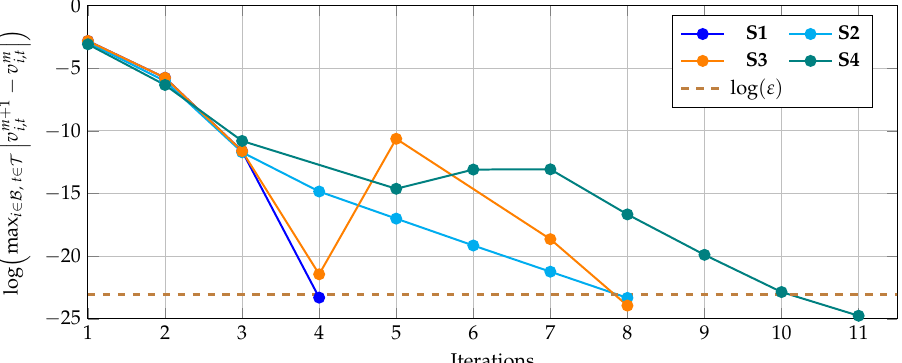
Figure 5. Evolution of the error in the proposed recursive approximation method in all the simu- lated